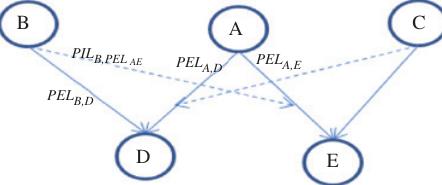
Figure 4: Using Components of PLDNN to Represent Logical